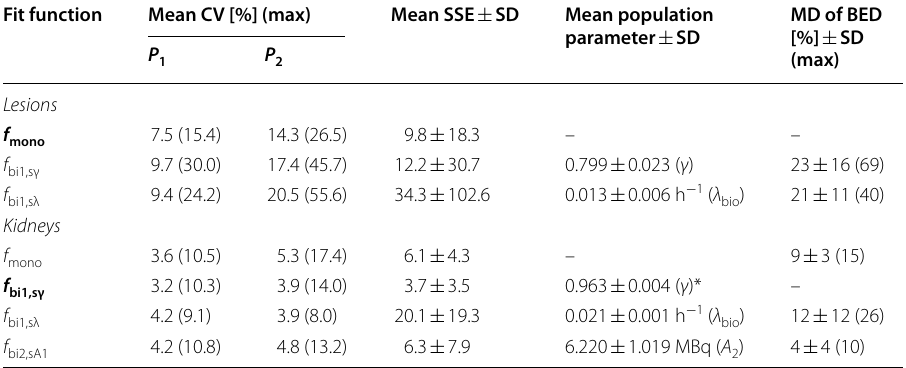
P 1 and P 2 refer to the respective two free parameters of each function. The functions for which the fit failed or the maximum CV was above 100% were neglected for model selection. The best-fit functions are highlighted by bold font. ( CV coefficient of variation, SSE sum of squared errors, SD standard deviation, MD mean absolute deviation) *Parameter value according to Hardiansyah et al.